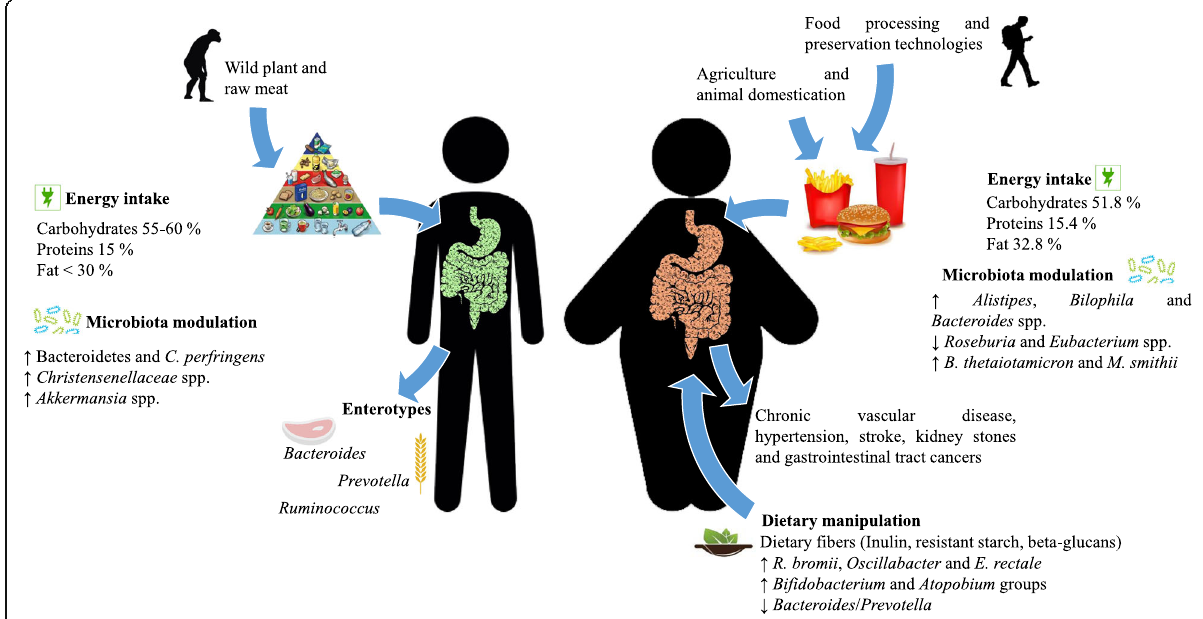
Fig. 1 Schematic representation of the diet – microbiota – obesity correlations. Interactions between diet and gut microbiota in lean and obese subjects: nutrition, energy intake, and microbiota modulation are reported. For lean individuals, possible microbiota enterotypes are